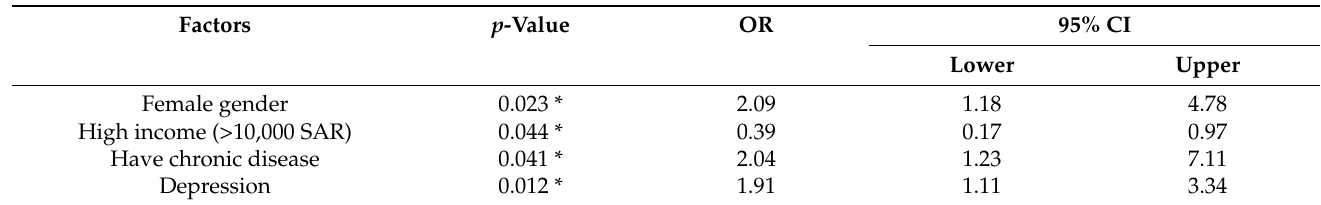
Table 4. Binary multivariate logistic regression of factors associated with alexithymia among medical students at King Khalid University, Saudi Arabia,